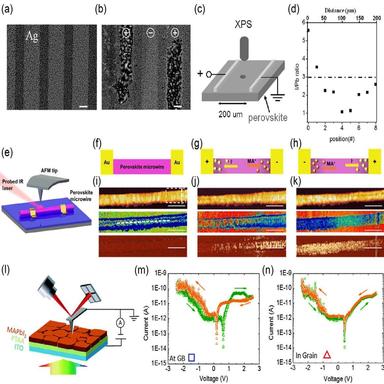
Top-view SEM of the perovskite lateral device with silver electrode before (a) and after (b) the poling. Scale bar: 20 lm. Copyright 2016, Wiley-VCH GmbH. (c) Illustration of the set-up for characterization of elements distribution using a lateral structure. (d) Distribution of the ratio of I/Pb between the electrode pairs after applying bias between two lateral electrodes. Copyright 2016, Wiley-VCH GmbH. (e) Schematic of the scattering-type near-field scanning optical microscopy